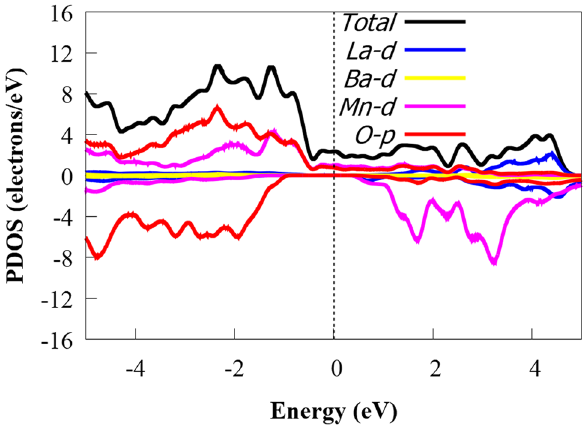
Fig. 5 Projected density of states of (PDOS) of 25% Ba-doped